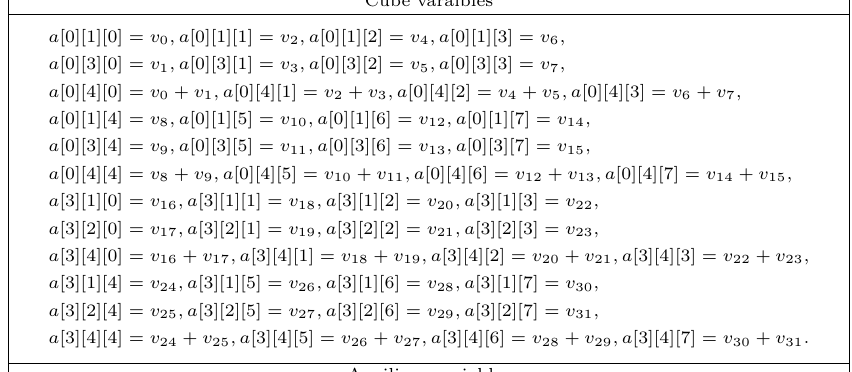
Table 13: A 32-dimensional cube for Ketje Jr V2 with 80-bit keys, where ( n a , n i ) = (22 , 25). In total, there are 40 bits key information involved in both auxiliary variables and involved key